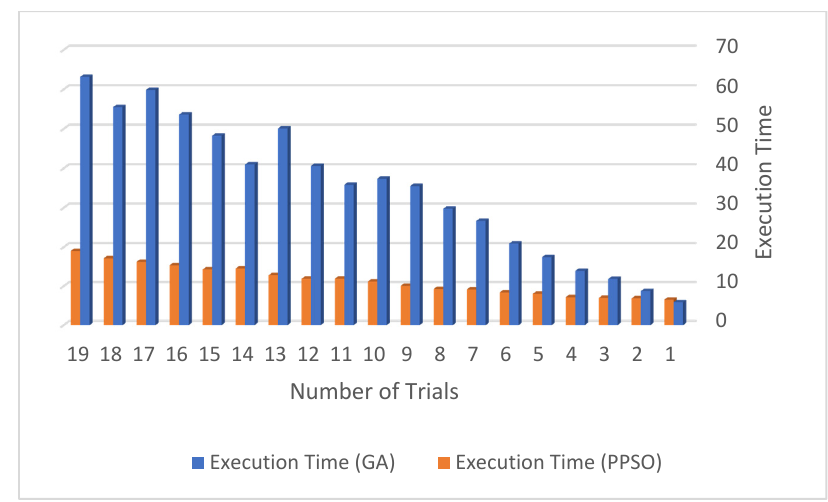
Figure 4. The comparison between GA and PPSO.